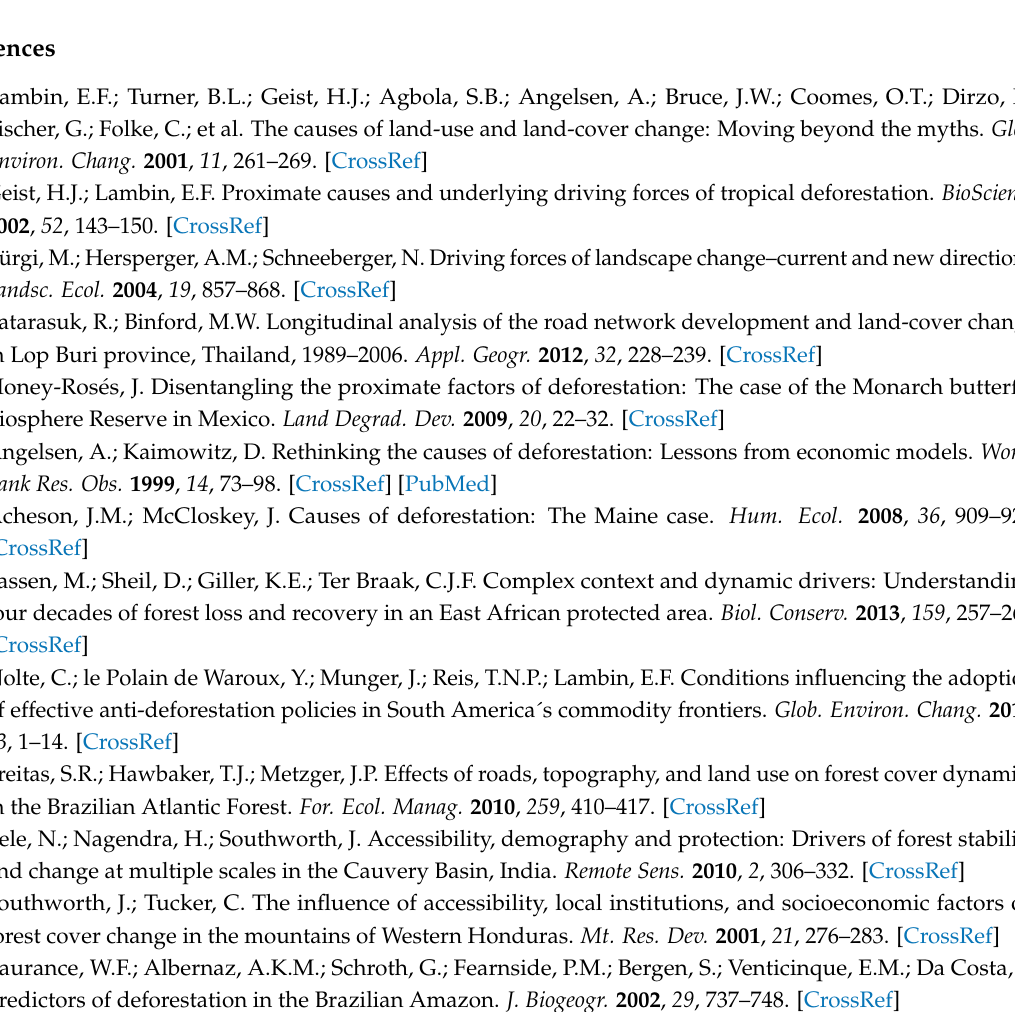
Figure S1: Land cover of the study area in 1979 and 2010 (modified from Hoyos et al. 2013). The location of the study area within Córdoba Province and in South America is indicated. Figure S2: Study area (a) and possible driving forces of land cover change: (b) altitude, (c) slope, (d) topographic position, (e) annual precipitation, (f) soil type/soil productivity index, (g) human settlements, (h)